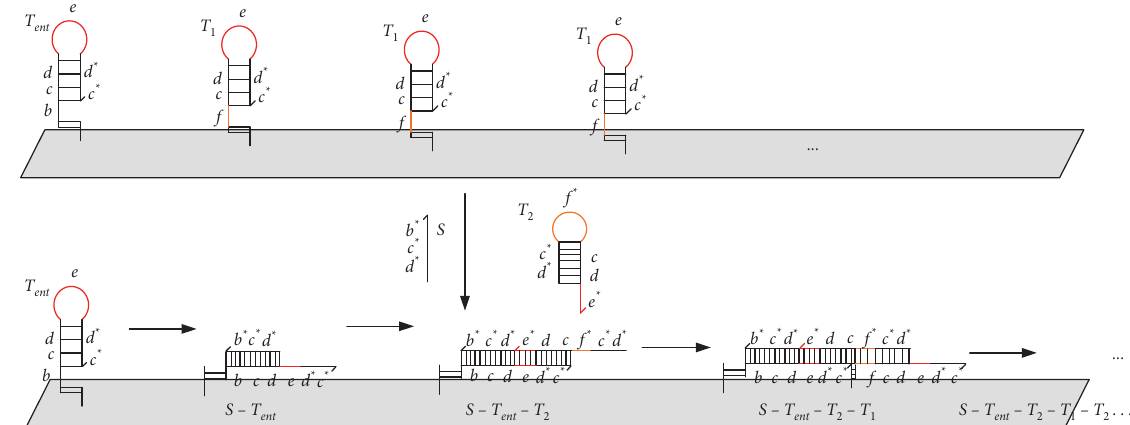
Figure 3: Principle of hybridization chain reaction.